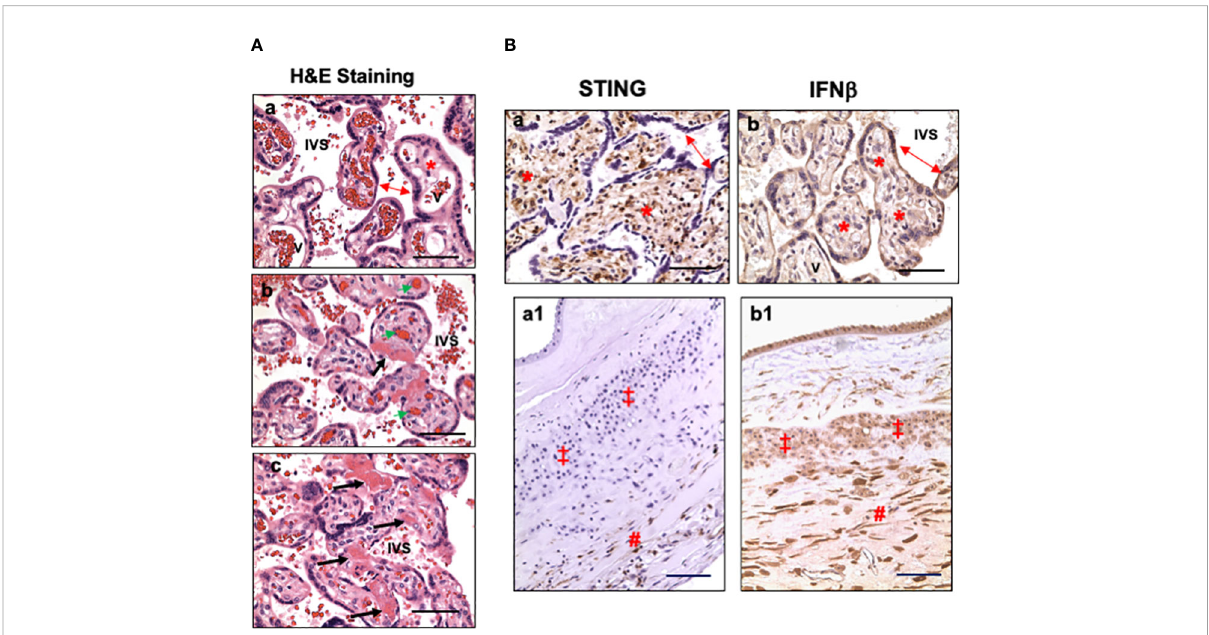
FIGURE 1 Representative villous tissue H&E staining and expression of STING and IFN b in villous tissue and fetal membrane in placentas exposed to maternal COVID-19 infection. (A) Representative villous tissue H&E staining in COVID-exposed (b and c) placentas compared to non-COVID control (a) showing features offetal vascular malperfusion including avascular villi, vascular thrombi, and perivascular fi brin deposition in villous tissue from COVID-19 exposed placentas. IVS: intervillous space; double arrow: STs; *: villous stroma; bold arrows: avascular villi and perivascular fi brin deposition; green arrow: fetal vessel thrombi. Bar = 50µm. (B) STING and IFN b expression in villous tissue and fetal membrane in placentas exposed to maternal COVID-19 infection. a and b: villous tissue; a1 and b1: fetal membrane; a and a1: STING; and b and b1: IFN b . In villous tissue: double arrow: STs; *: villous stroma. In fetal membrane: ‡ : EVTs; #: decidua. Bar = 50µm in a and b; Bar = 100µm in a1 and